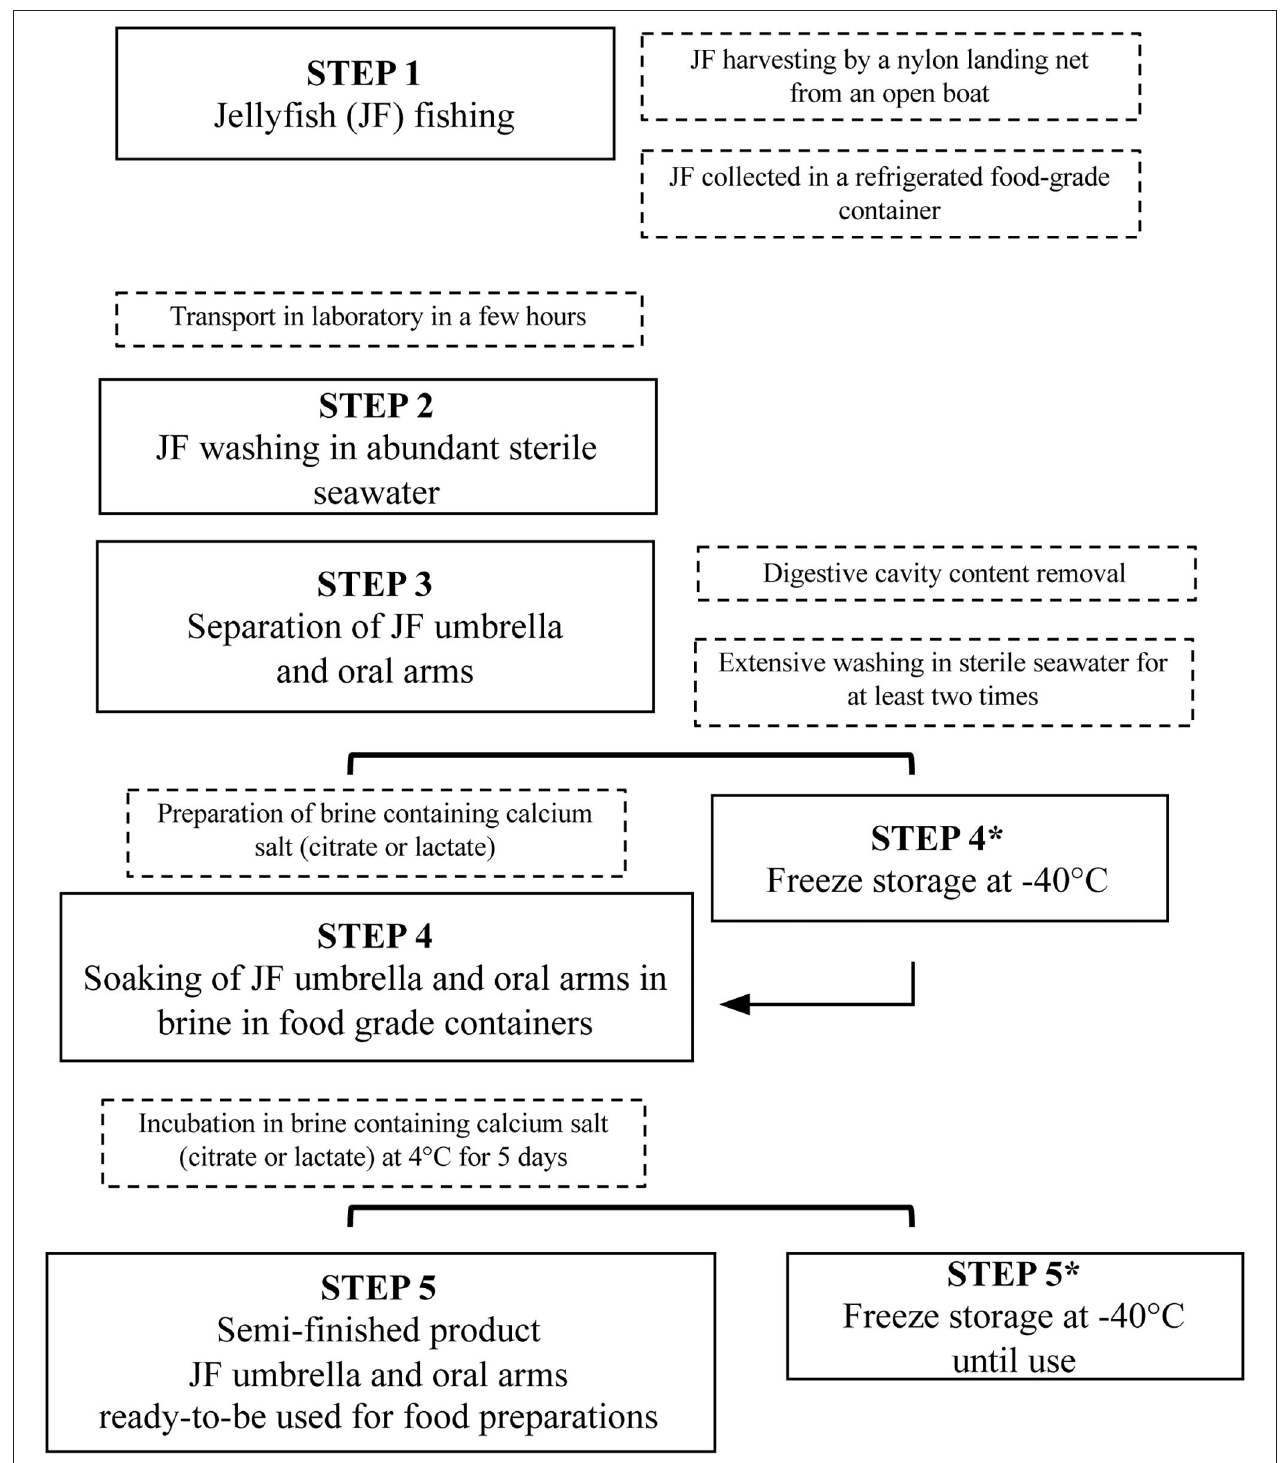
FIGURE 4 | Diagram illustrating the procedure of the new proposed JF treatment method. from sponges and bacterioplankton (55). In fact, they should be monitored and their presence should be reduced as a precautionary measure, at least, while waiting for more detailed